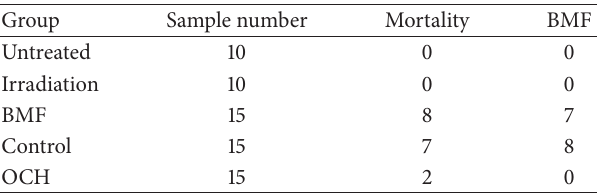
Table 3: Incidence of mortality and BMF in mice with different